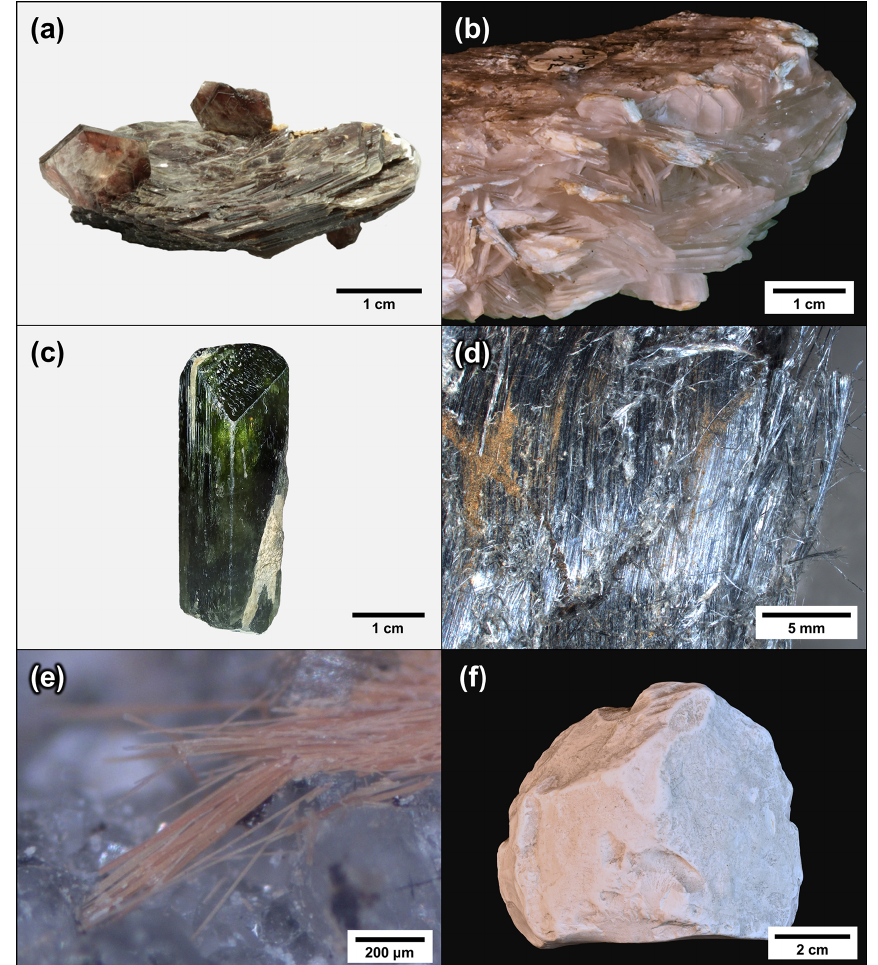
Figure 8. Habits of modular rock-forming minerals. Layered minerals (a) muscovite (mica group) and (b) brucite typically form platy habits due to the planar nature of T - O - T layer modules. Pyribole-series minerals typically form (c) stubby to prismatic (diopside, pyroxene group) and (d) acicular to asbestiform (riebeckite var. crocidolite, amphibole supergroup) habits elongated on the crystallographic axis c , which reflects the linear nature of T - O - T rod modules. The highly strained T − – T + linkages in palysepiole-series minerals lead to (e) acicular habits (windmountainite, palygorskite group) elongated on the crystallographic axis c and (f) mineral aggregates where the growth of macrocrystals is inhibited